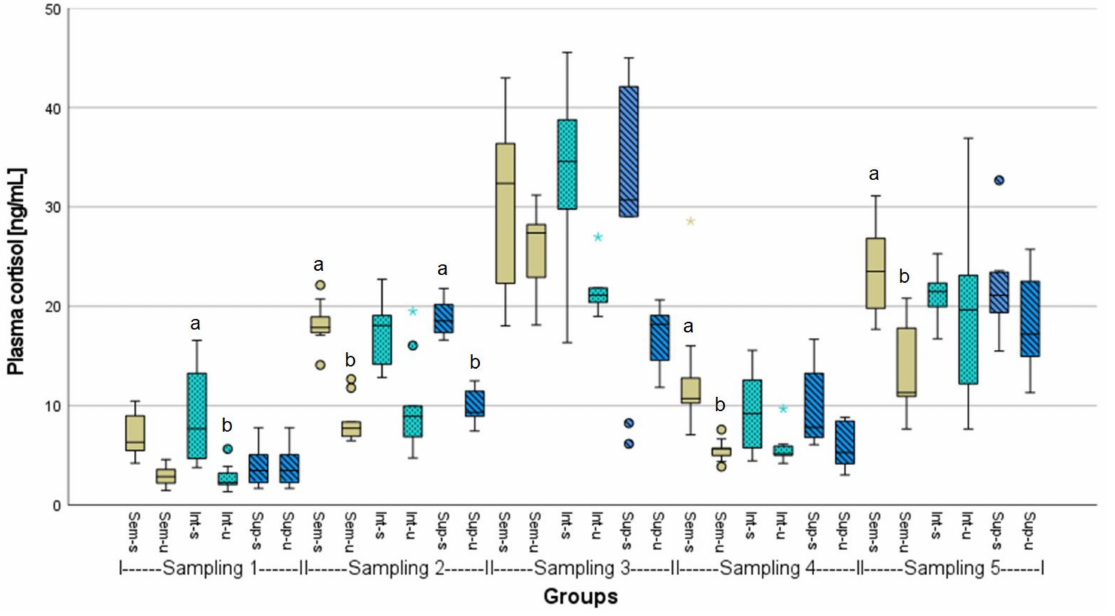
Figure 1. Plasma cortisol responses of stressed (s) or unstressed (u) African catfish (n = 9) under three different stocking densities (Sem = semi-intensive, Int = intensive, Sup = super-intensive). Kruskal- Wallis test with Tukey-HSD or Dunnett-T3 post hoc test, significances ( p < 0.05) are only given within the respective samplings, marked by letters. Circlets = outliers; asterisks = extreme values.